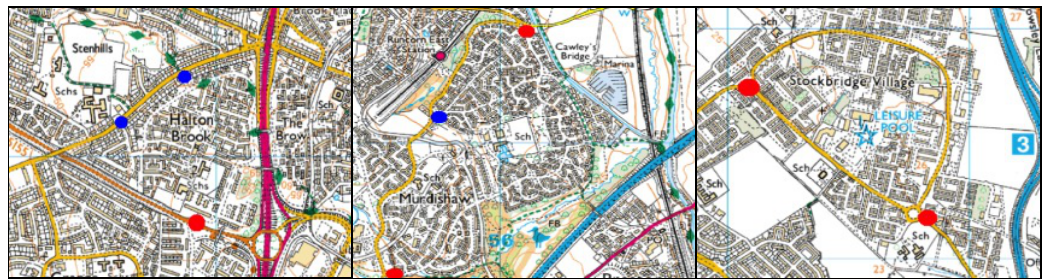
Figure 7. Road networks and connectivity in HB, Murdishaw, and SV. Major and secondary access points are marked with red and blue dots, respectively. *A* roads are in gold, *B* roads are in brown. The M57 motorway is blue.